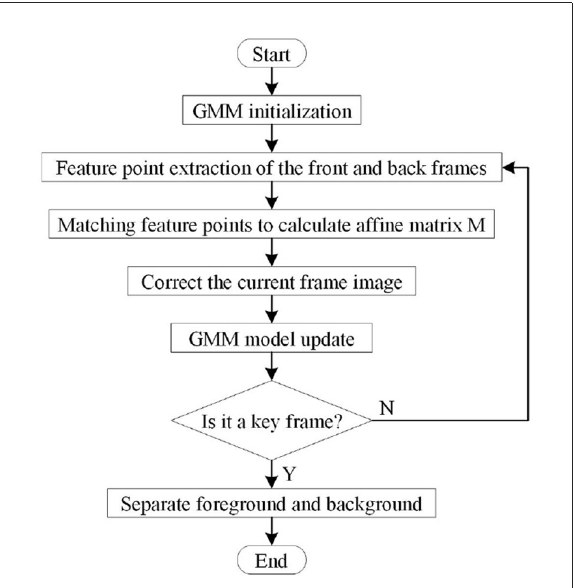
FIGURE3 Flow chart of dynamic target detection combining GMM and affine matrix.